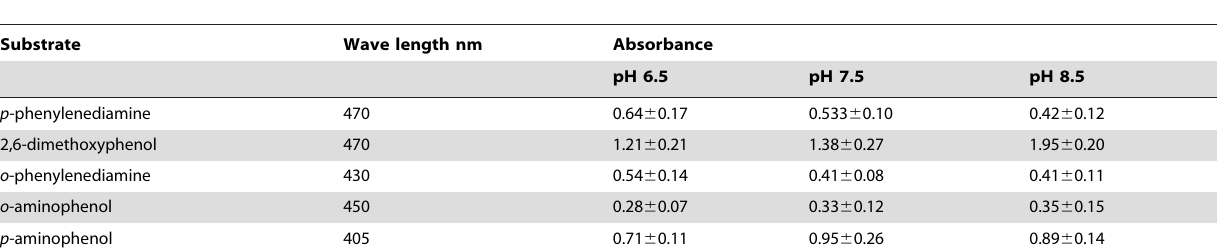
Table 2. Oxidation activity of Lac15D for PPD, OPD, OAP, DMP, and PAP under different pHs.